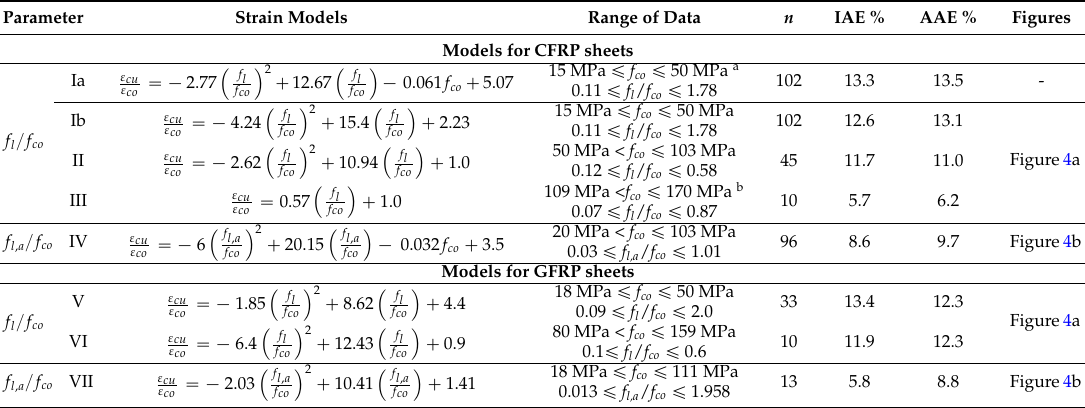
Table 3. The strain models developed in this study and prediction capacity.